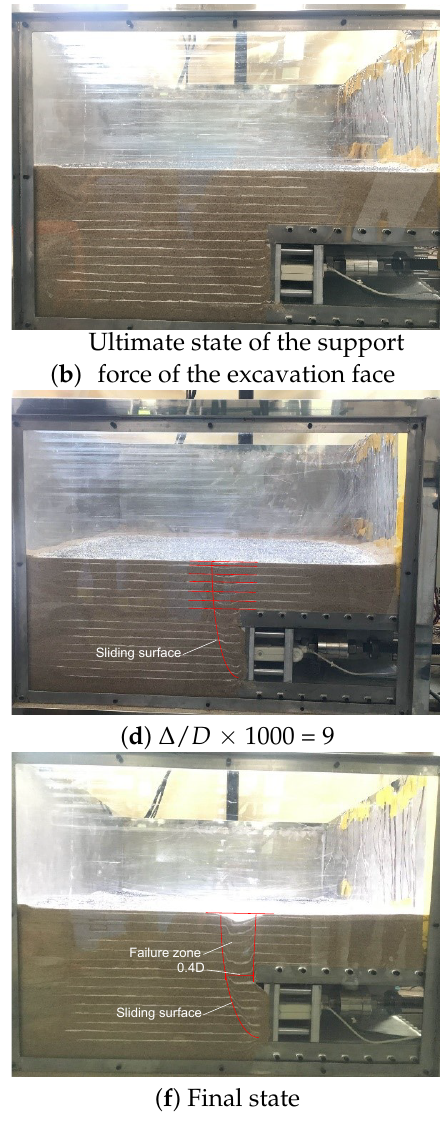
Figure 20. Instability process development during a test without the pipe roof ( C / D =